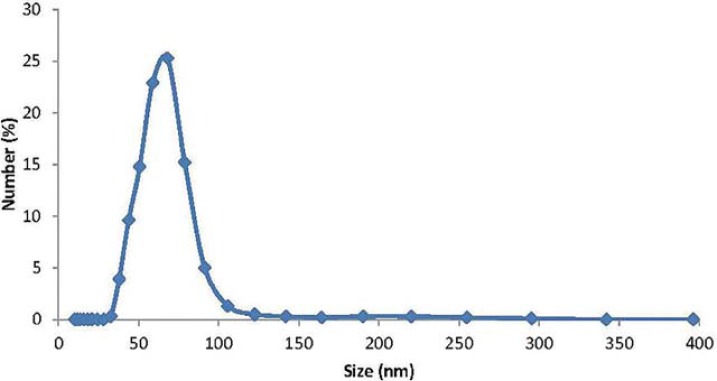
 Particle size distribution for the AgNPs